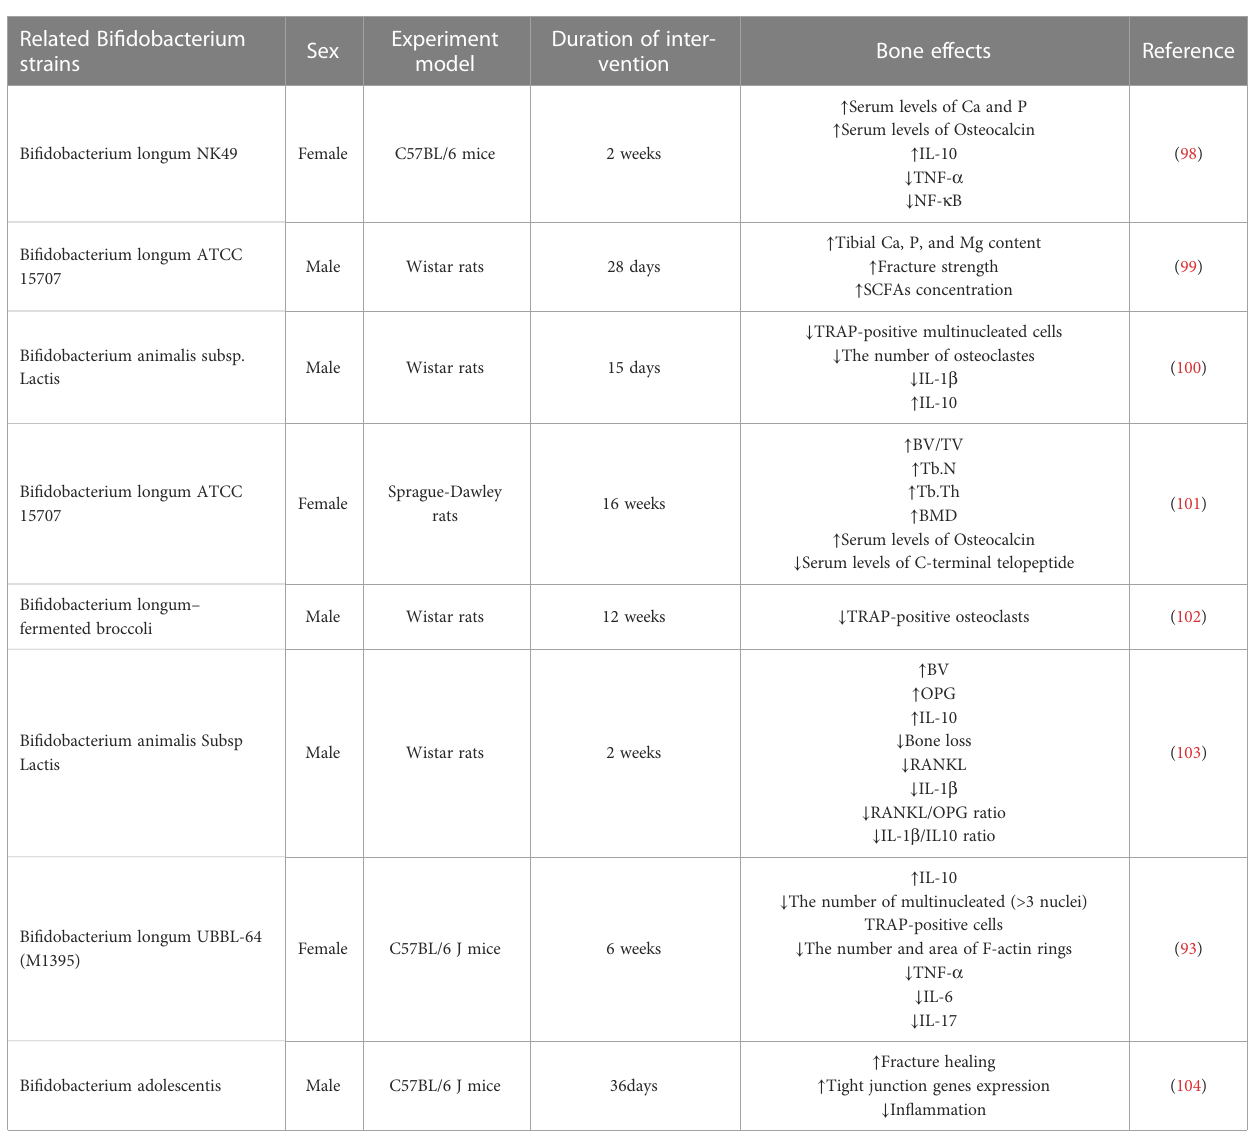
TABLE 1 Bene fi cial effects of related Bi fi dobacterium strains on bone health. Related Bi fi